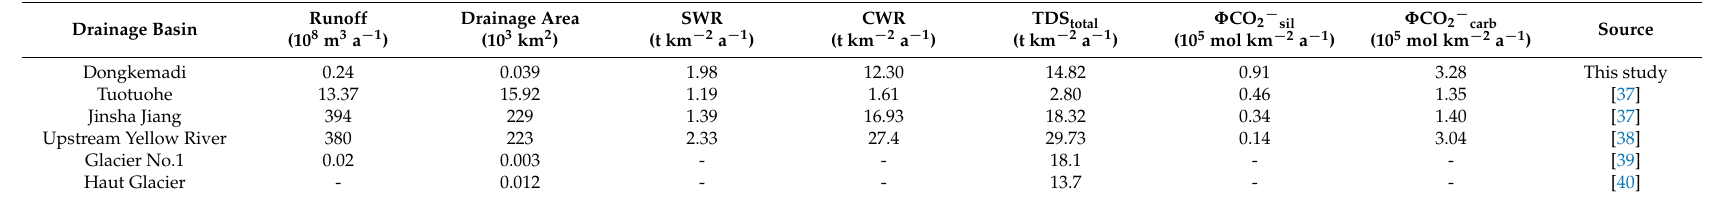
Table 2. Chemical weathering and CO 2 consumption rate in the Dongkemadi River